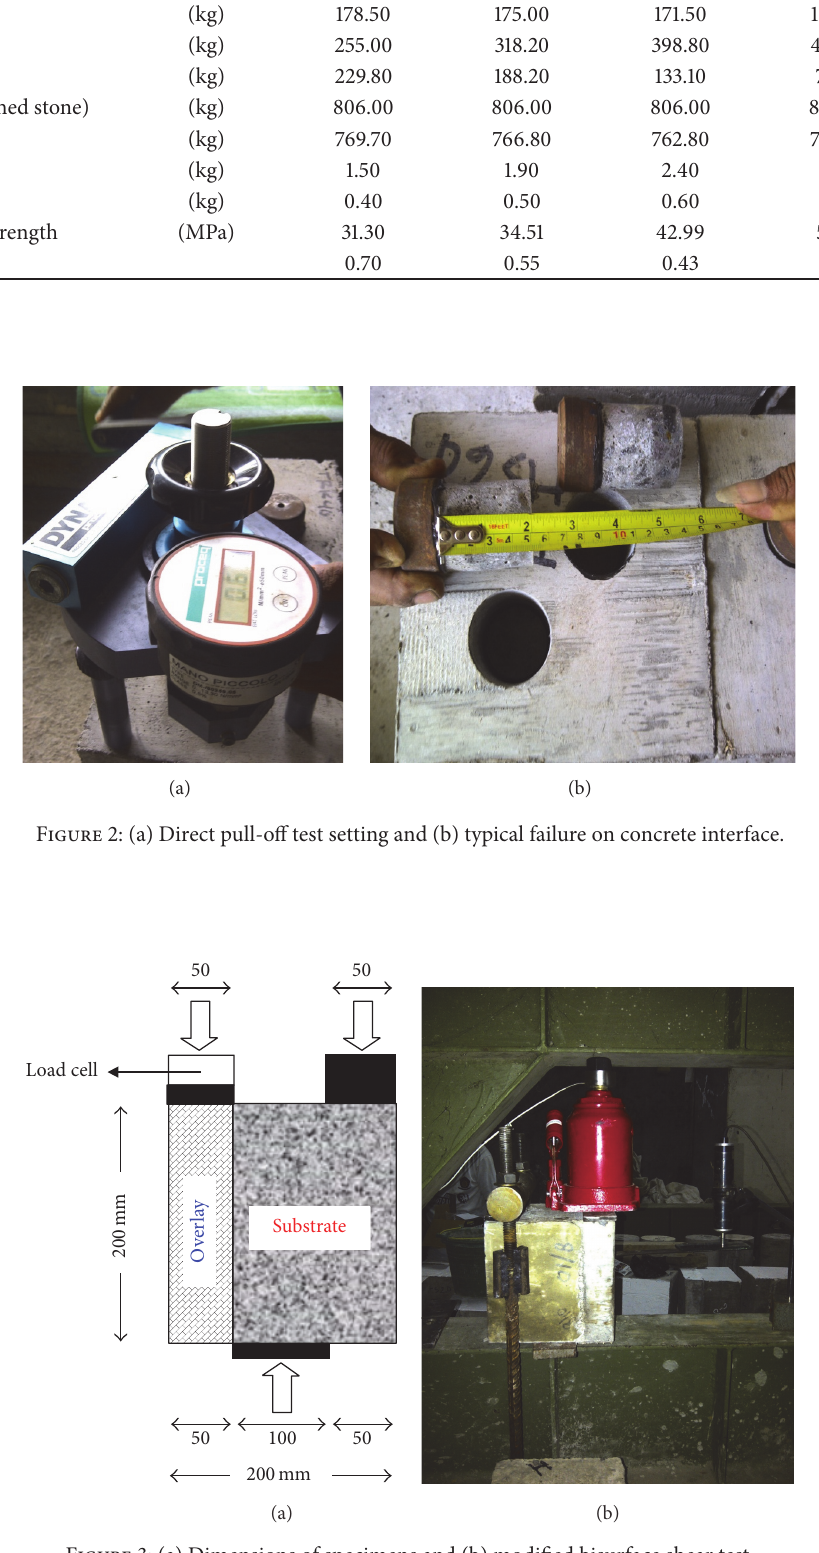
Figure 3: (a) Dimensions of specimens and (b) modified bisurface shear